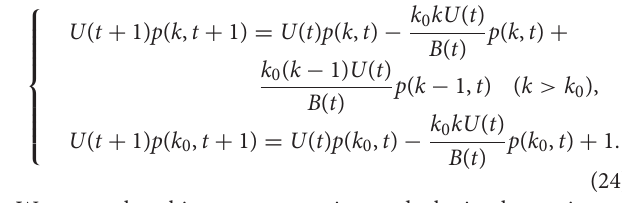
newly added at each time step. Then following a stochastic rule, the edges of new node are connected to the existing